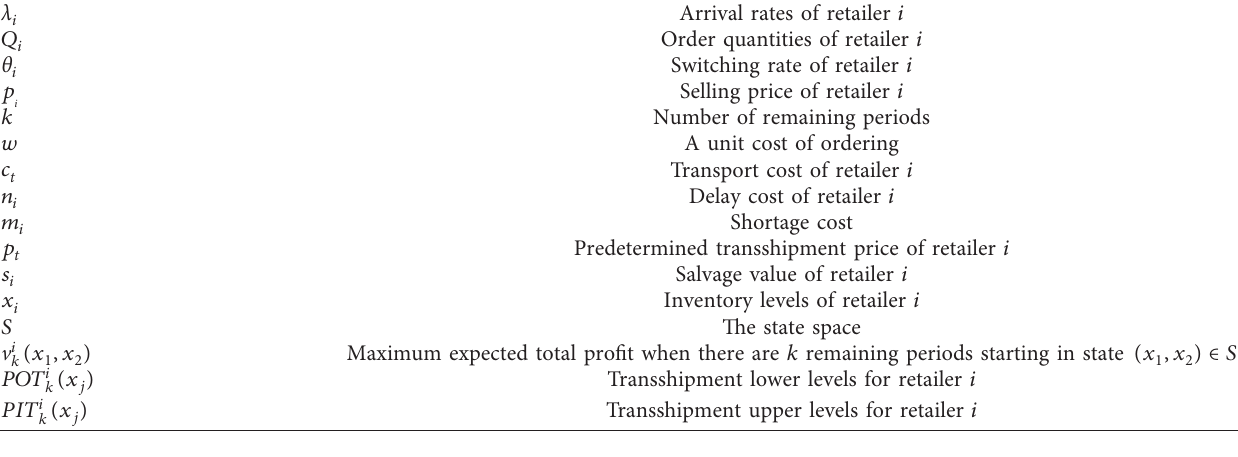
Table 1: List of